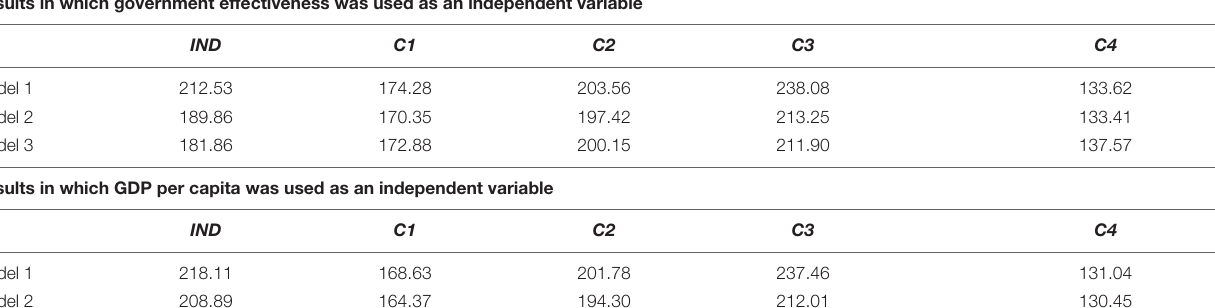
FIGURE 3 | Posterior distributions of the estimated values of slopes in Model 3. (A) Results using government effectiveness as an independent variable. (B) Results using GDP per capita as an independent variable instead of government effectiveness. Squares and circles represent posterior means of slopes affecting government effectiveness (or GDP per capita) and pathogen stress, respectively. Each number on the horizontal axis represents a global region (1 = Sub-Saharan Africa, 2 = East Asia and Pacific, 3 = Europe and Central Asia, 4 = Latin America and Caribbean, 5 = Middle East and North Africa, and 6 = South Asia). µ in horizontal axis represents global slopes across global regions (i.e., µ GE , µ GDP , or µ PS ). Each error bar represents a 95% Bayesian credible interval. TABLE 2 | WAIC values of each model (IND: Individualism , C1: Conformity 1 , C2: Conformity 2 , C3, Conformity 3 , C4: Conformity 4 ). Results in which government effectiveness was used as an independent